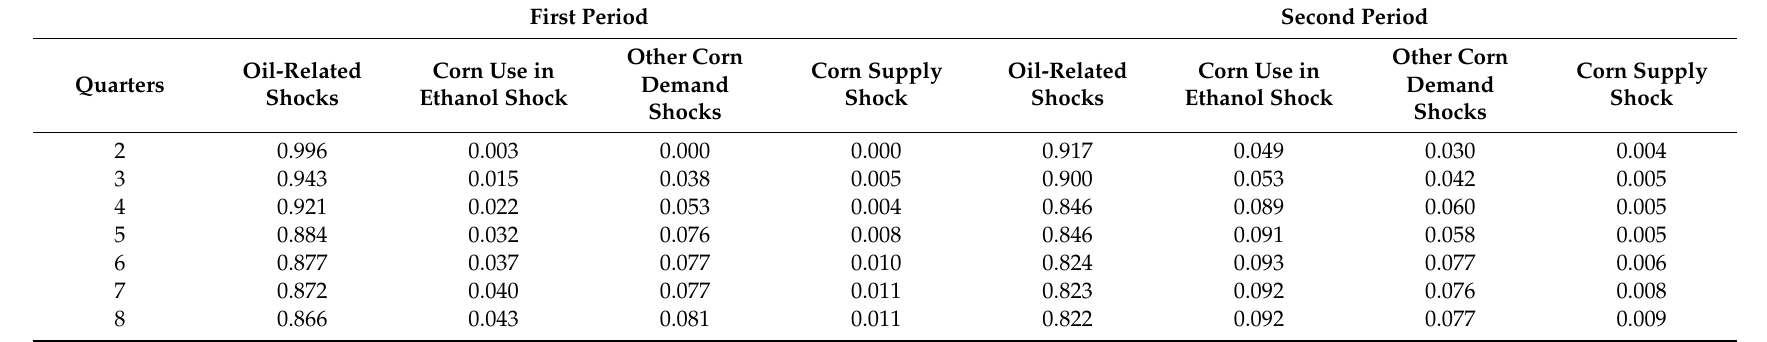
Table 5. Percentage contribution to oil price variation (after the decomposition of corn